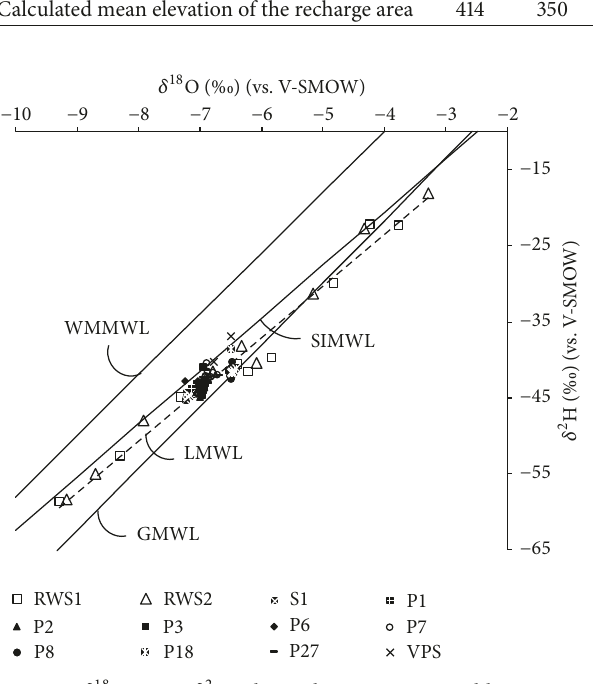
Figure 5: 𝛿 18 O versus 𝛿 2 H relationship in mean monthly rainwater samples, collected in RWS1 (square) and RWS1 (triangle), and in spring and groundwater samples. LMWL is the Local Meteoric Water Line ( 𝛿 2 H = 6.78𝛿 18 O + 3.65 ), and GMLW is the Global Meteoric Water Line [28].